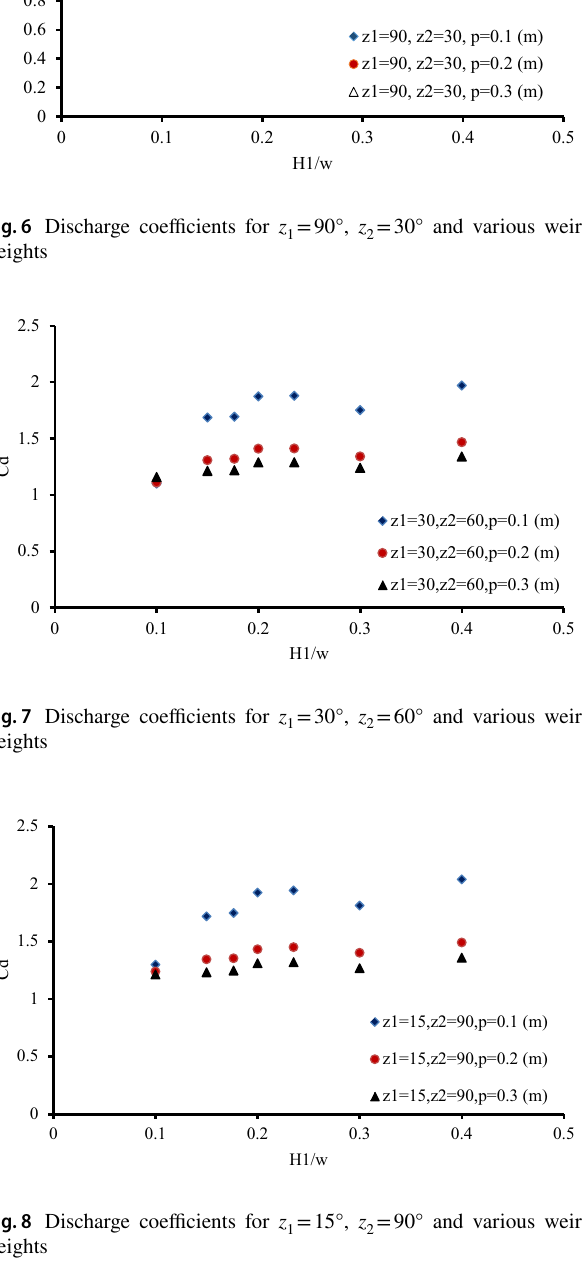
w = 0.85 m and various 2 = 60°,